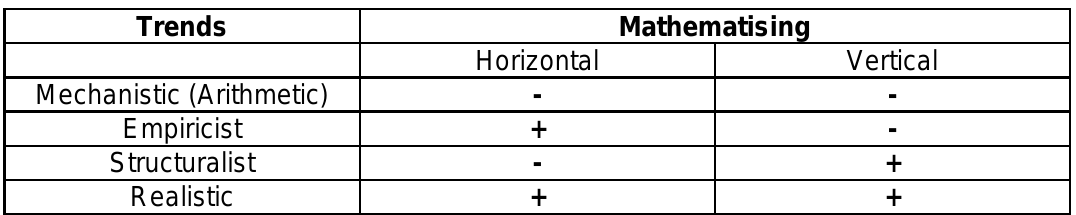
Table 1. Classification by Treffers of inclusion of horizontal and vertical mathematisation in four different mathematics education